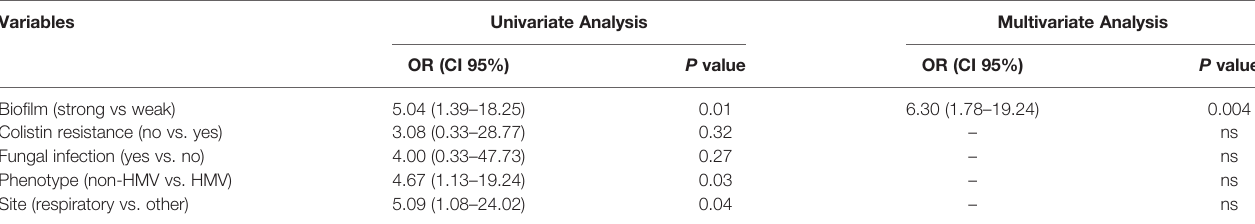
TABLE 3 | Univariate and multivariate analyses of factors associated with for 30-day mortality in 53 patients infected with carbapenem-resistant K. pneumoniae .